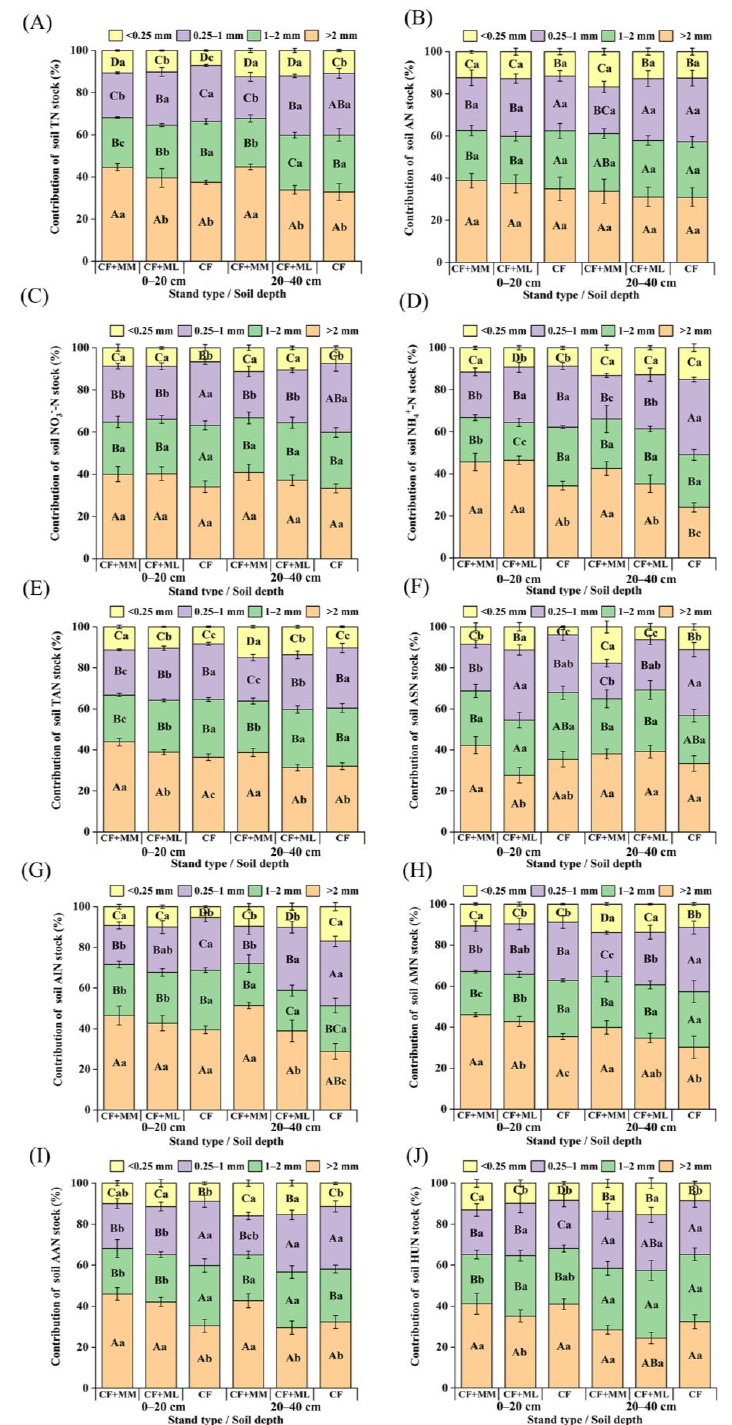
Figure 5. Contribution of soil total nitrogen (TN), available nitrogen (AN), nitrate nitrogen (NO 3 − -N), ammonium nitrogen (NH 4+ -N), total acidolysable nitrogen (TAN), amino sugar nitrogen (ASN), nonacidolyzable nitrogen (AIN), cidolyzable ammonia nitrogen (AMN), amino acid nitrogen (AAN), and unknown acidizable nitrogen (NUN) stocks in various sized aggregates to bulk soil in Chinese fir plantations with different stand types in 0–20 and 20–40 cm ( A – J ) soil depth. Different capital letters stand for significant differences ( p < 0.05) among different aggregate sizes in the same forest types. Different lowercase letters represent significant differences ( p < 0.05) among different stand types with the same